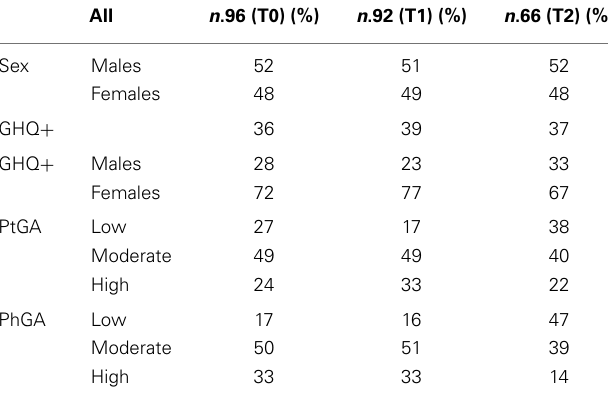
Table 3 | Gender, GHQ status, and disease severity reported by patients and by physicians at each assessment (numbers and percentages) .